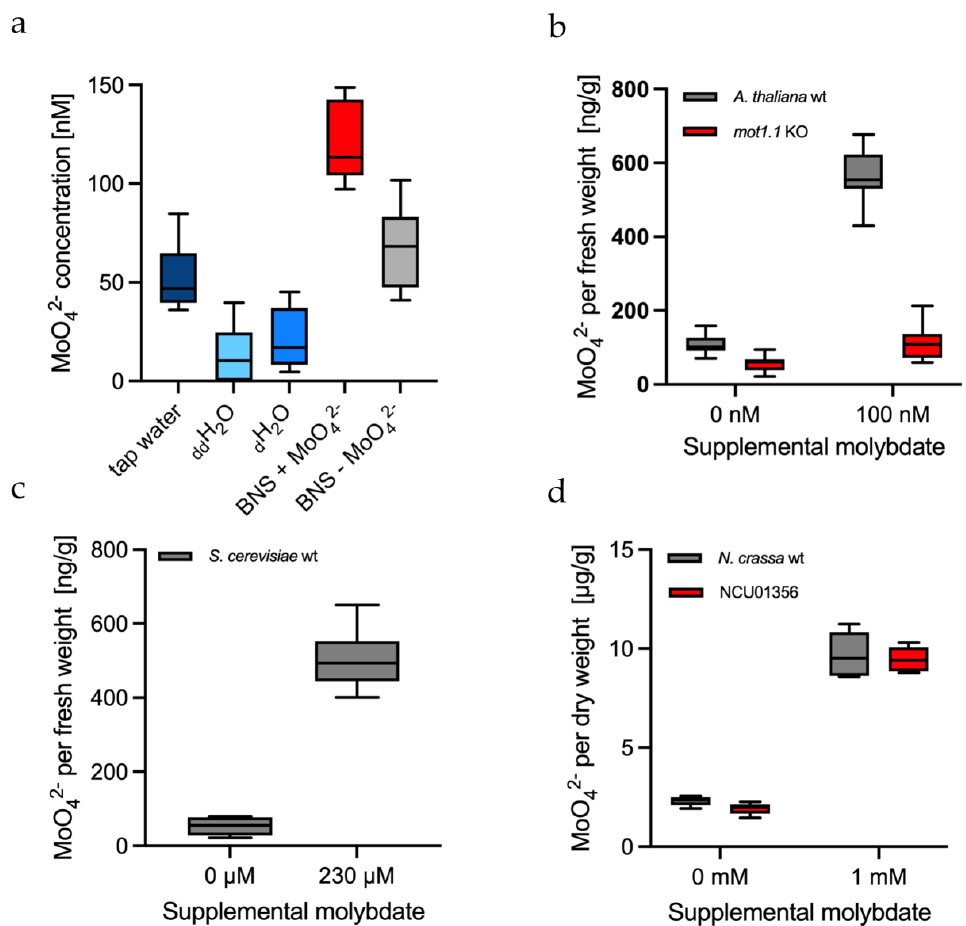
Figure 4. MolyProbe-Strep in vitro assay in culture media and cell extracts: ( a ) Water and culture media from left to right: tap water; dd H 2 O; d H 2 O; hydroponic BNS (see Materials and Methods) medium with 100 nM molybdate; hydroponic BNS medium without molybdate. n = 4; ( b ) Cell extracts of Arabidopsis thaliana plants cultivated in hydroponics with and without 100 nM molybdate. The roots were removed, and the remaining plant parts were collected, homogenized and measured in a 96-well plate. The A. thaliana strains that were used were molybdate transporter 1.1 knock-out ( mot1.1 KO) and the Col-1 wild-type (wt) strain. Biological replicates, n = 4 (without molybdate)